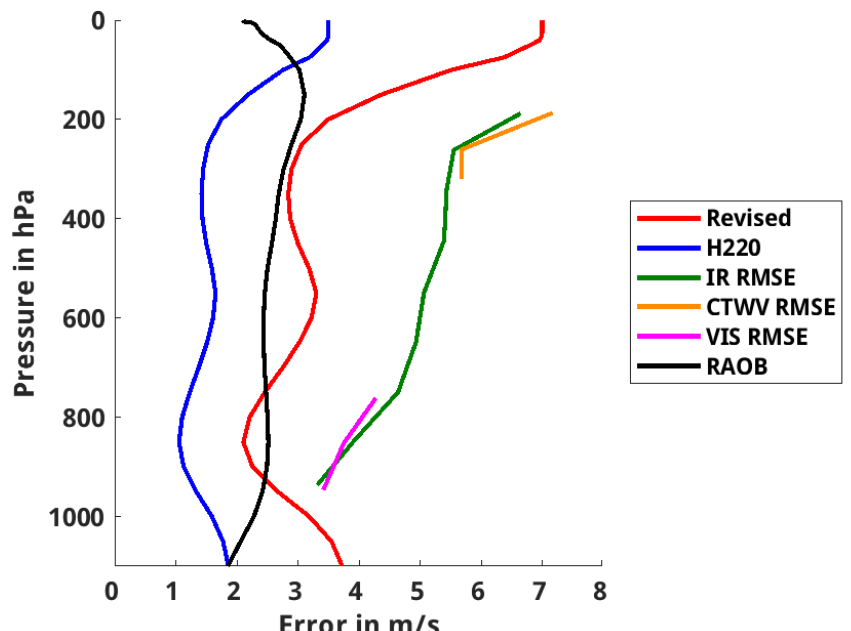
Figure 4. Proposed profile of observational wind error as a function of pressure used for IR-,CTWV-, SWIR-, CAWV-, and VIS-type AMVs (red), rawinsonde is in black and the control (H220) is in blue. Also plotted are the root-mean-square error (RMSE) from comparing GOES-16 AMVs with rawinsonde derived by the data provider.